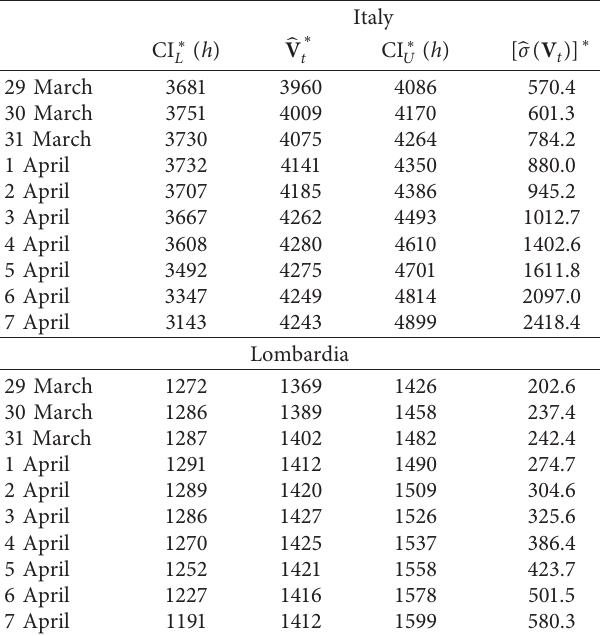
Table 2: 10-step-ahead predictions for the variable Ut (people in